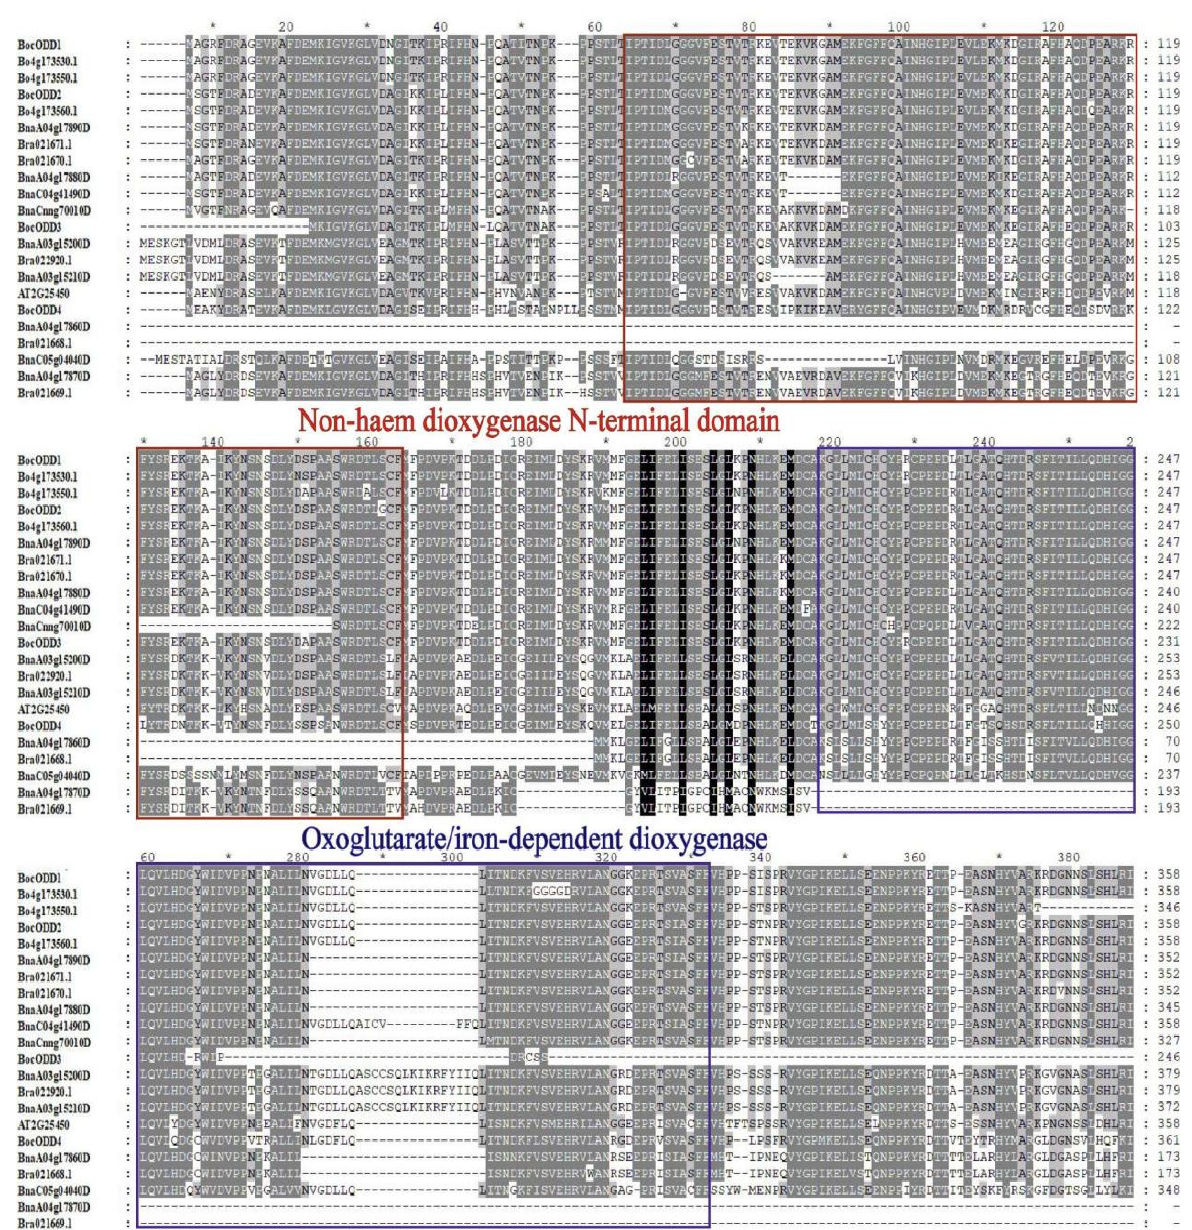
Figure 4. Amino acid sequence alignment of ODD proteins from Chinese kale , Brassica oleracea , Brassica rapa , Brassica napus, and Arabidopsis thaliana . The non-haem dioxygenase N-terminal domain and oxoglutarate/iron-dependent dioxygenase are boxed in red and blue, respectively. The expression level of BocODD1 in the transgenic plants OE-ODD1-1 and OE-ODD1- 8 were higher than the wild type plants. The expression level of BocODD2 was 2.4 and 2.5 times higher, respectively, in the OE-ODD2-3 and OE-ODD2-5 compared to the wild type plants (Figure 7G,H). The expression level of BocODD1 and BocODD2 in RNAi-ODD-9 was one-sixth that of the WT, while the expression level of BocODD1 was significantly lower in RNAi-ODD-26 compared to that of the WT plants. The expression level of BocODD2 in both of the RNAi plants was significantly lower compared to the WT plants (Figure